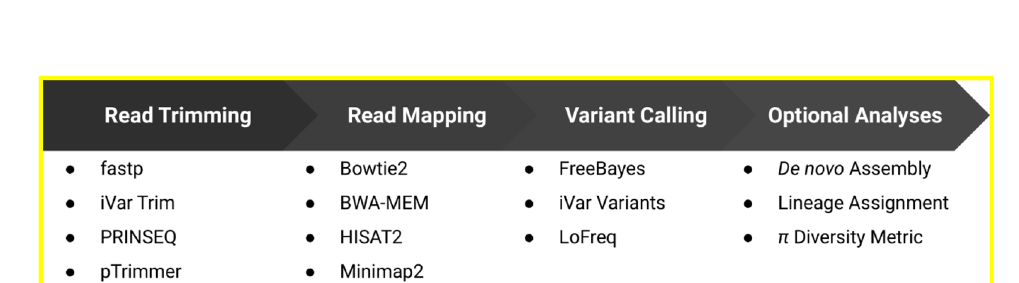
Figure 1. ViReflow pipeline. Vireflow implements a standard viral consensus sequence reconstruction pipeline, with multiple tool choices for each step of the pipeline. The output consensus sequence is produced by incorporating high-depth variant calls into the reference genome